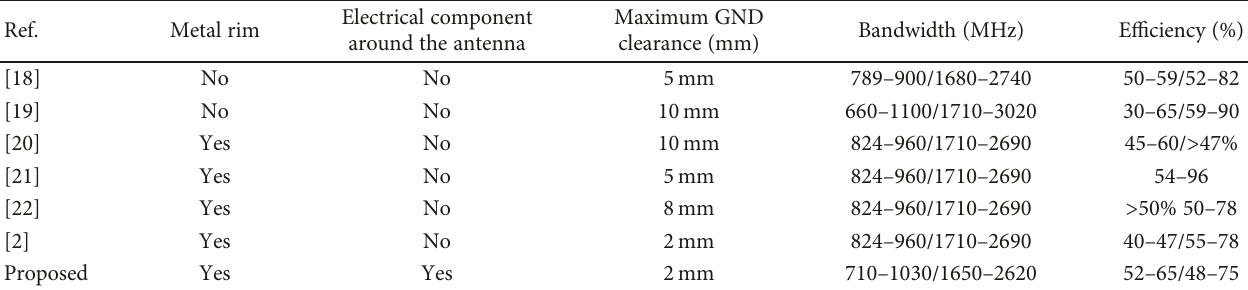
Table 1: Comparison of proposed antenna and reference antennas.